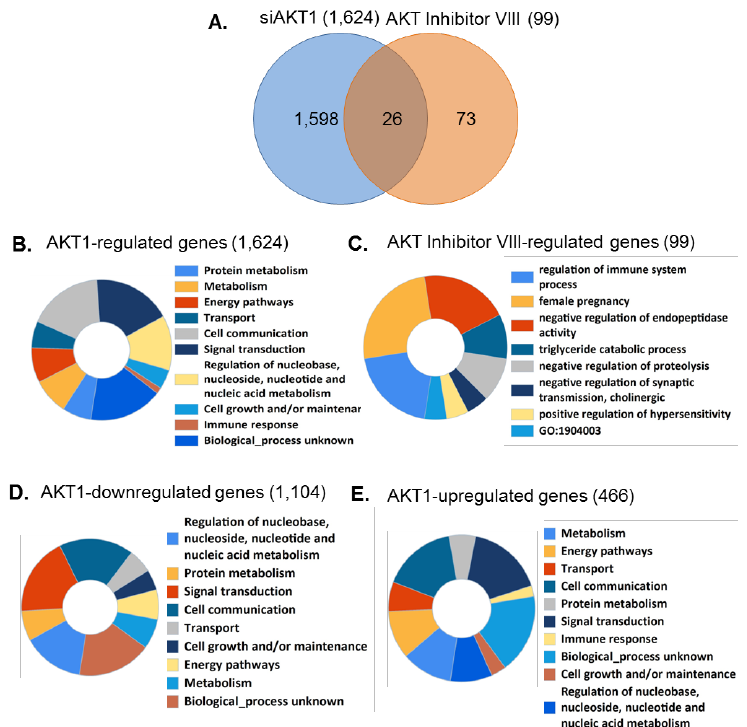
Figure 4. Pathway and functional analysis of AKT1-dependent differentially altered genes. ( A ) Venn diagram showing the shared and unique genes regulated by AKT1 and/or AKT inhibitor VIII; ( B ) doughnut chart showing the functional annotation of differentially expressed genes upon AKT1 silencing using siAKT1; ( C ) doughnut chart showing the functional annotation of differentially expressed genes upon using the Pan-AKT Inhibitor VIII; ( D ) doughnut chart showing the func- tional annotation of downregulated genes upon AKT1 silencing; and ( E ) doughnut chart showing the functional annotation of upregulated genes upon AKT1 silencing.